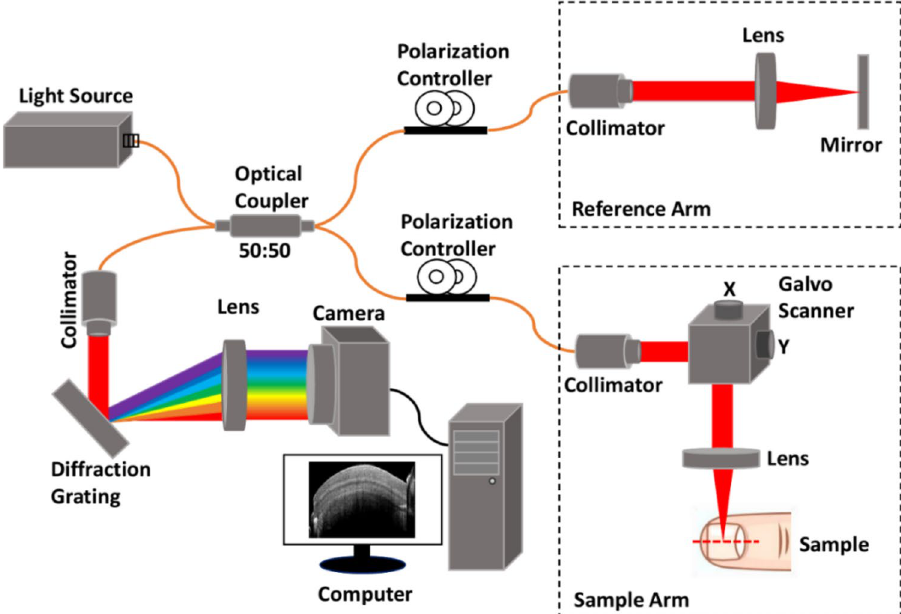
Figure 1. Schematic of the spectral-domain optical coherence tomography